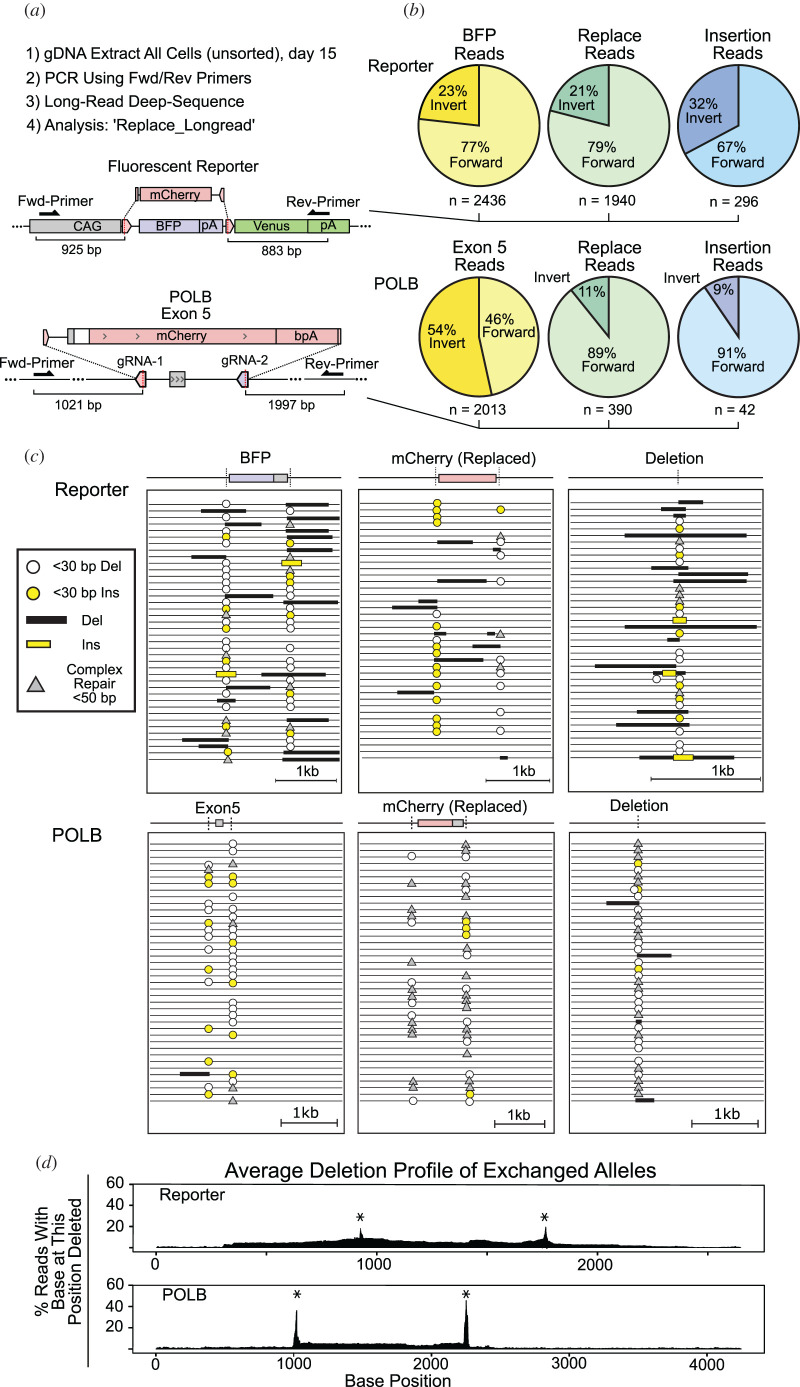
Long-read deep sequencing of Replace targeted cells. (a) Unsorted HeLa reporter cells or K562 POLB exon 5 targeted cells. Loci were amplified using the primers more than 800 bp from the Cas9 breaksites; amplicons were sequenced using PacBio technology (b). Directionality of structural variants formed after Replace targeting. BFP/exon 5 pie charts are alleles containing the original targeted allele and no donor. mCherry pie charts show alleles where mCherry replaced targeted sequence. Insertion is both donor sequence and targeted sequence in the loci. (c) Forty representative alignments of three major type of alleles: allele with original sequence, sequence exchanged with mCherry, or a deletion allele. (d) An average deletion profile of reads in which Replace editing using the mCherry donor was successful. Alignments were analysed for the fraction of reads containing a deletion at each base position. Asterisk denotes Cas9 cleavage site.